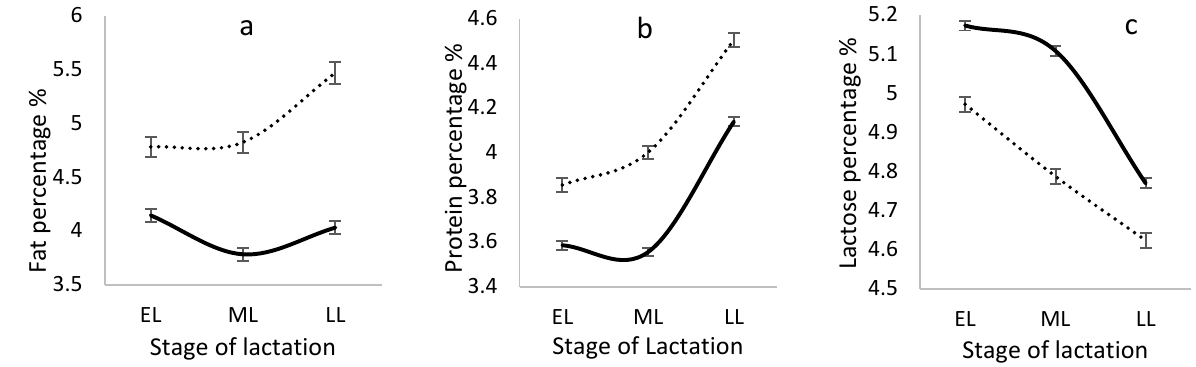
Figure 1. Daily yields of ( a ) milk, ( b ) fat, ( c ) protein and ( d ) lactose in cows milked OAD ( . . . .) and TAD (—) during the production season 2020–2021. EL = early lactation (<90 days); ML = mid lactation (90–180 days); LL = late lactation (>180 days). The vertical bars show the standard errors. The p -values for the interaction between milking frequency and stage of lactation were <0.0001 for daily yield of milk, fat, protein and lactose.